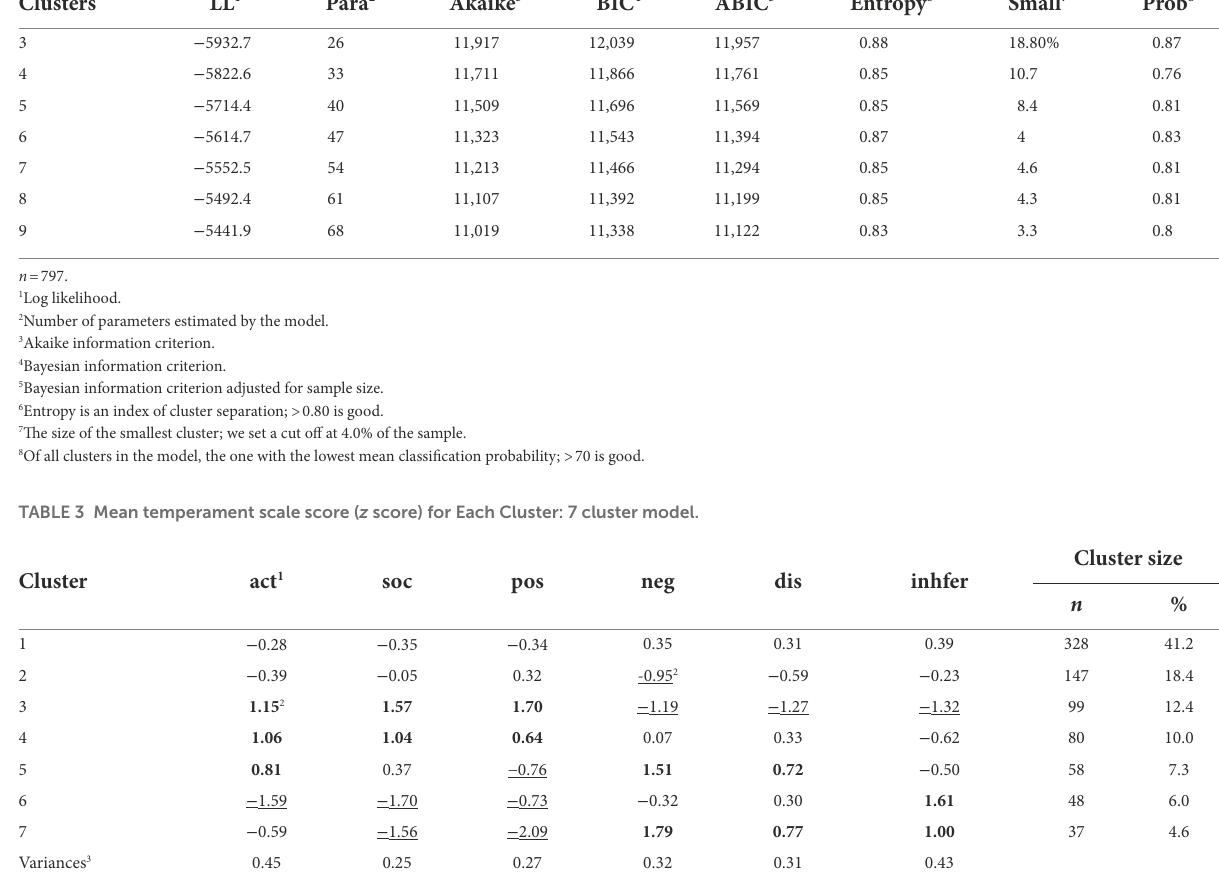
TABLE 2 Results of latent profile analysis: six temperament indicators. Clusters